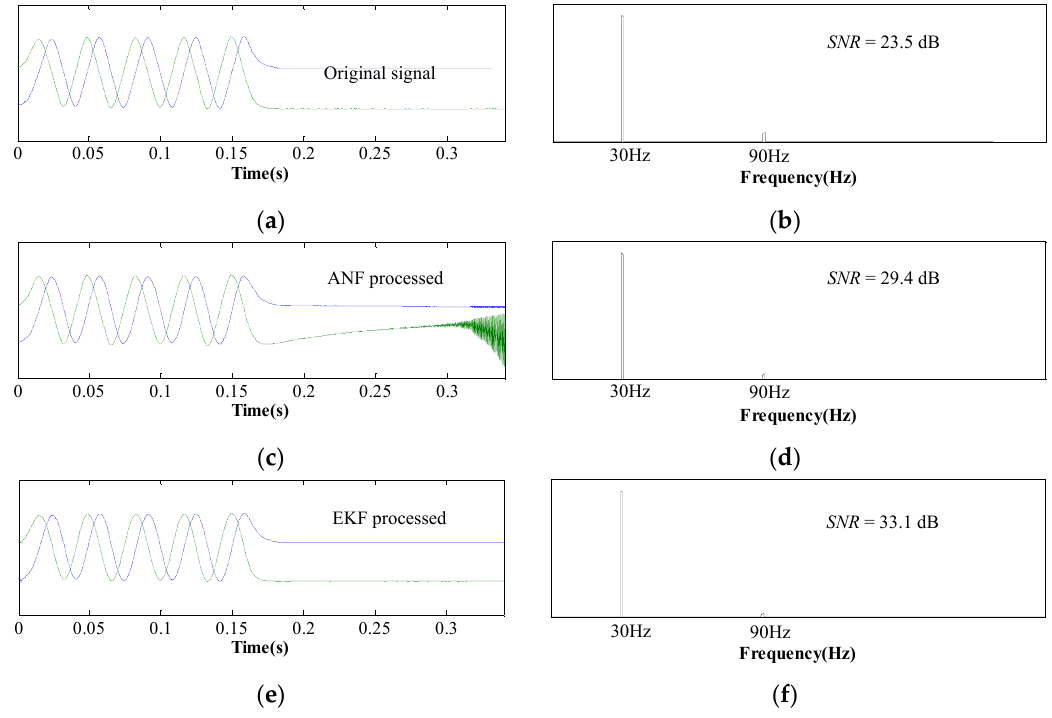
Figure 8. Waveforms and FFT results of sensor signals at 600 mm/s. ( a , b ) Original sensor signals. ( c , d ) ANF processed signals. ( e , f ) EKF processed signals.